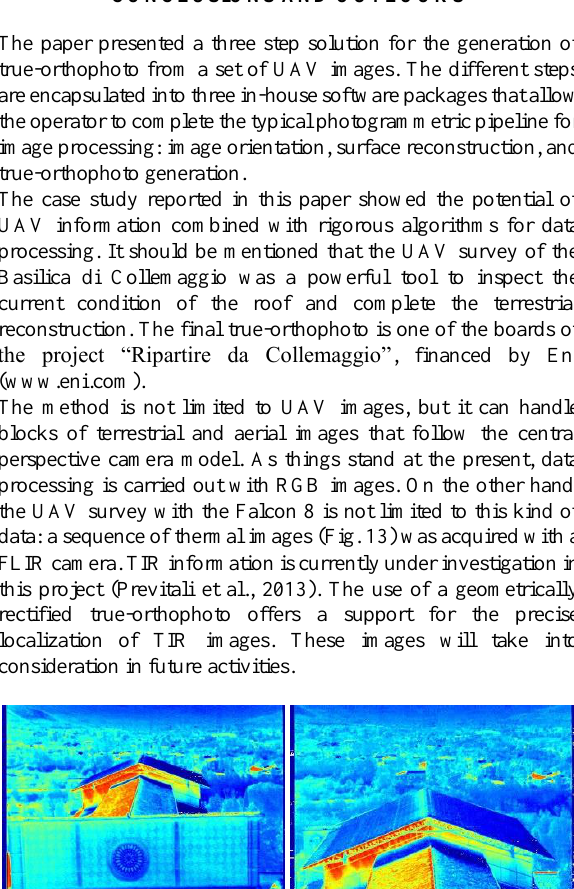
Fig. 13. Two thermal images acquired with the Falcon